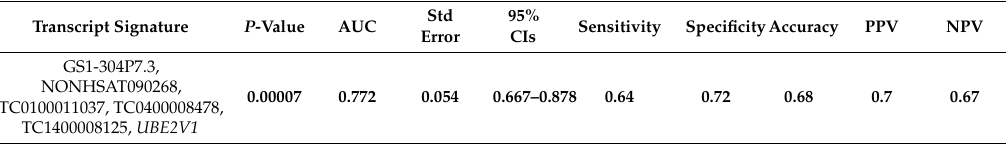
Table 3. Features of the ROC curve computed on all DE transcripts. The p -value of the curve, the AUC, its standard error (Std error), and the 95% CIs are shown; sensitivity, specificity, accuracy, PPV and NPV are also shown. Significant values are highlighted in